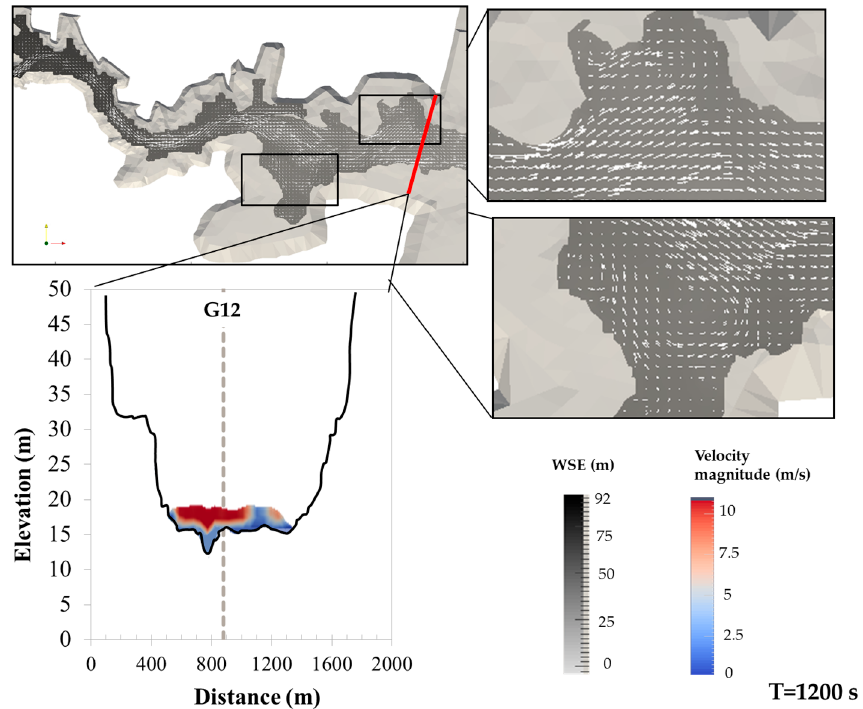
Figure 11. Free surface flow at 1200 s in the whole domain and in two details (boxes on the top right) after the collapse of the dam, in terms of velocity vectors and water surface elevation. River cross section through point G12 is highlighted in red. Velocity magnitude in this section varies from 0 to 10.8 m/s. Water 2016 , 8 , 545